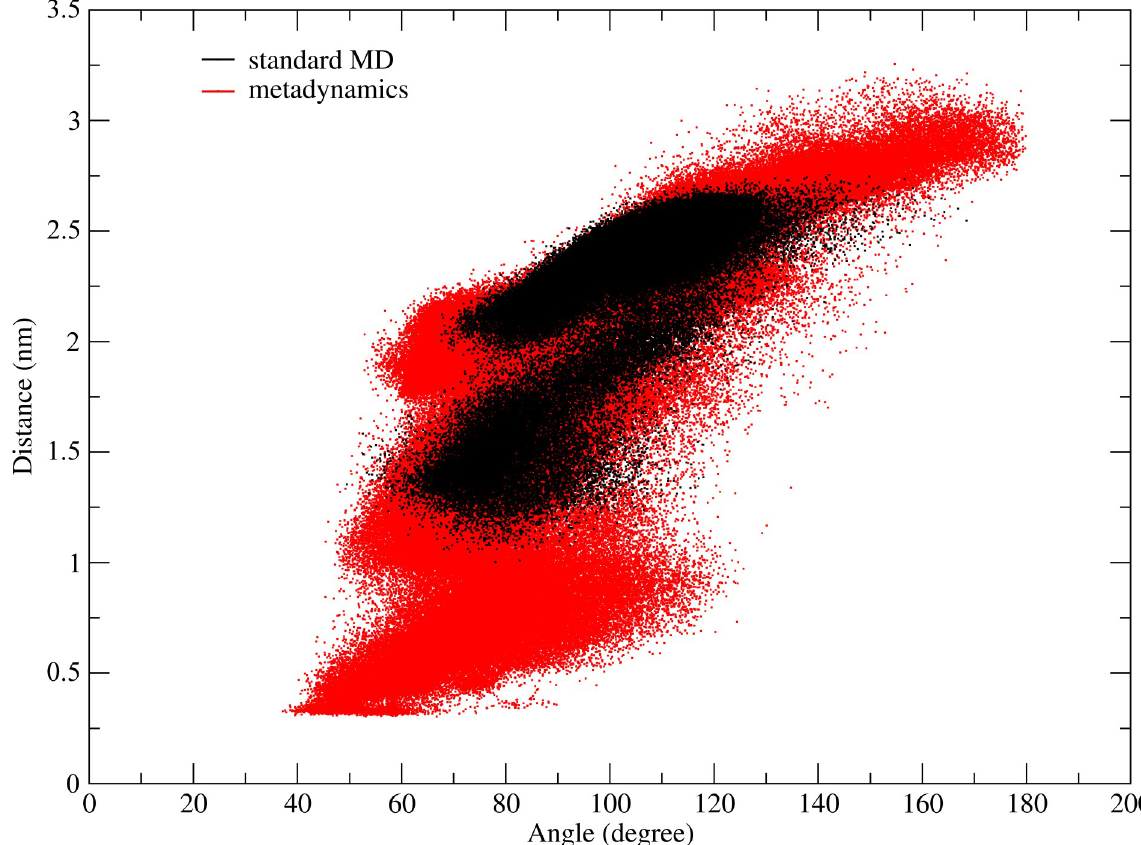
Fig 5. Two-dimensional visualization of the hinge peptide’s sampled conformational space. Plotting the opening angle against the W3 –W3’ distance as a descriptor for twisting of the β -hairpins by taking the geometric center of every tryptophan side-chain atom. The conformational space sampled during standard MD is visualized in black while the metadynamics simulation is shown in